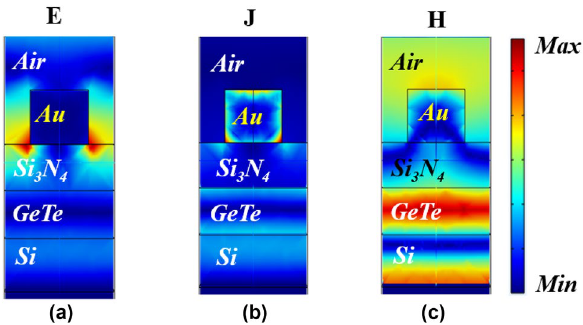
Figure 9. Spatial distribution of ( a ) normalized electric field; ( b ) normalized current density and; ( c ) normalized magnetic field of the absorber on resonant wavelength at 1550 nm and m = 0%.